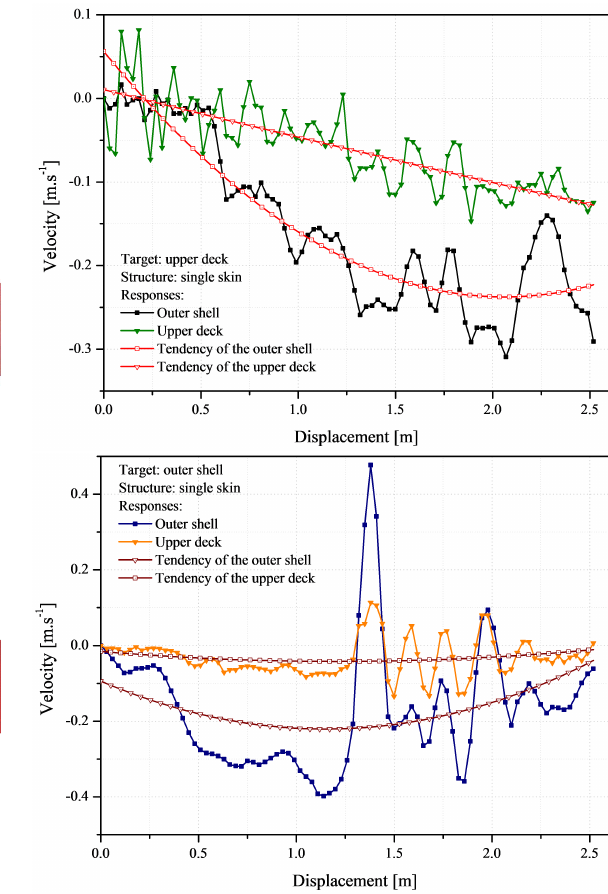
orange contours, or approximately in member displace- ment 0.308-1.403 m. Significant disparity is observed on the DSS’s shell compared to the SSS’s which contours